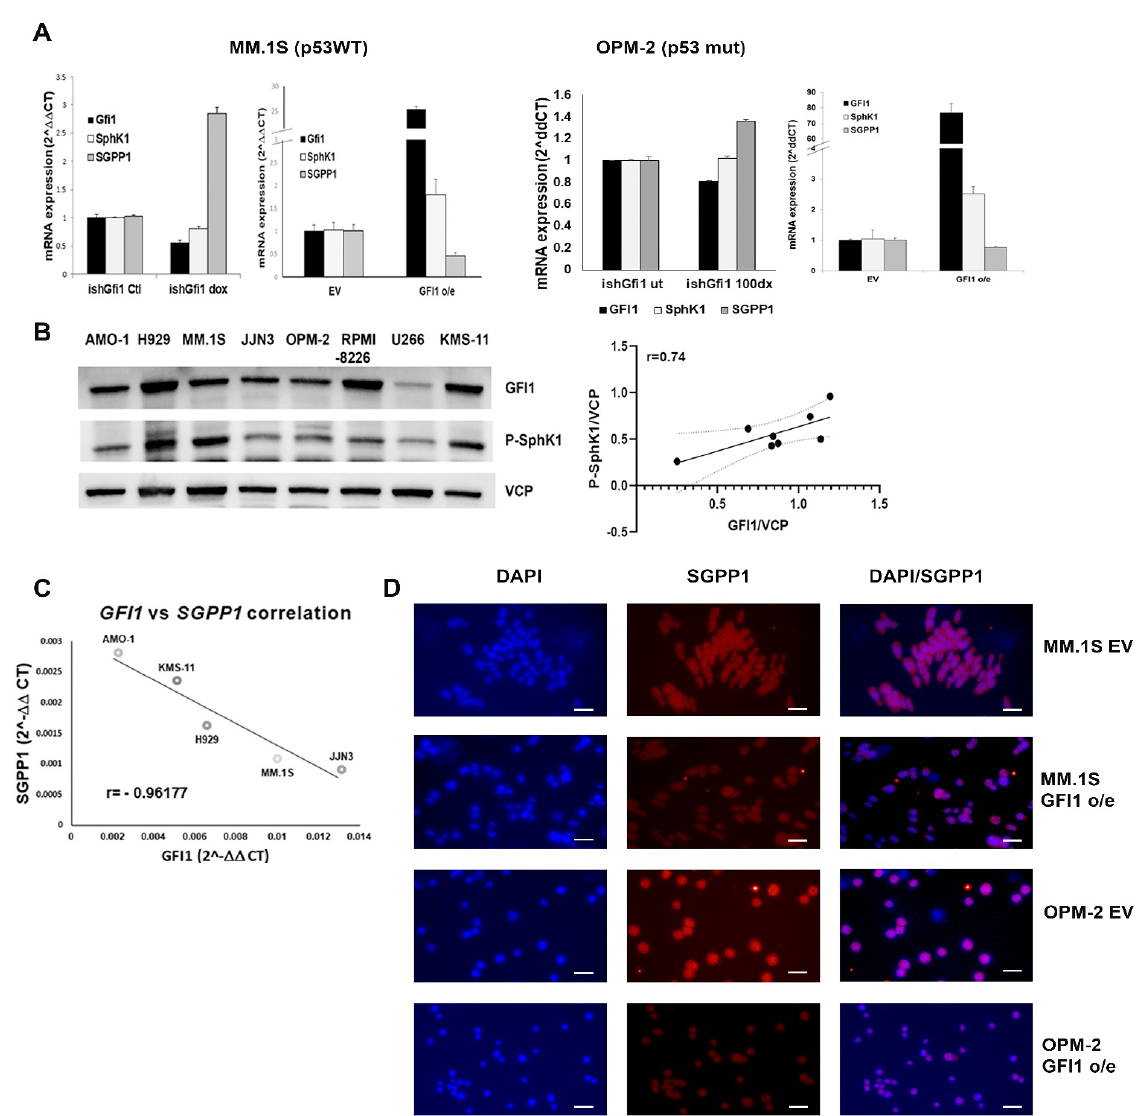
schematic Figure S1), in MM cell lines with altered GFI1 expression. We found that SphK1 mRNA levels were downregulated when GFI1 was knocked-down (KD) by a doxycycline- inducible shGFI1 construct in both MM.1S ishGFI1 (p53 WT) and OPM-2 ishGFI1 (p53 mut), whereas SGPP1 mRNA was significantly upregulated when GFI1 levels were decreased (Figure 1A,B left panels).